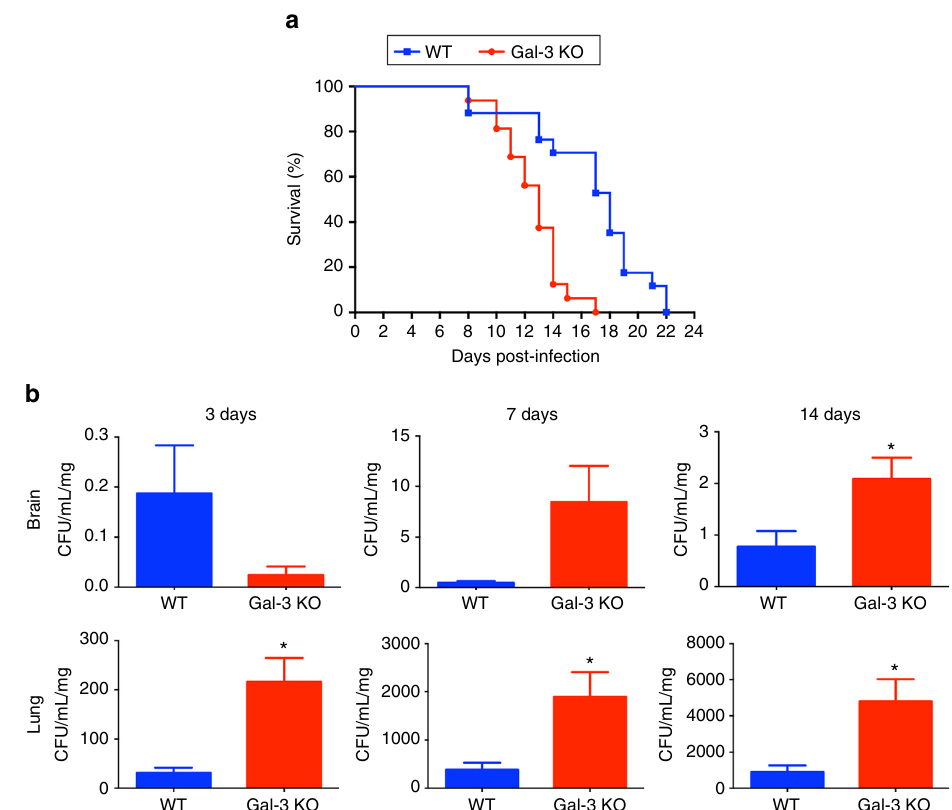
Fig. 3 Absence of Gal-3 leads to lower survival and increased fungal burden in experimental murine cryptococcosis. The survival rate ( a ) of Gal-3 KO mice (red line with circle) and WT mice (blue line with square) were veri fi ed after intratracheally infection with H99 yeast cells. b Colony-forming units (CFU) recovered from brain and lungs of WT (blue bars) and Gal-3 KO (red bars) mice were assessed after 3, 7, and 14 days after intratracheally infected with C . neoformans . The y -axis denotes CFU/ml/mg resulting from normalization of fungal burden to the weight of the organ fragment used to prepare the homogenate. Data are representative of three experiments, each performed with eight mice per group. The bars represent the mean ± SD of CFU obtained from triplicate samples in groups of eight animals. * p < 0.05, Student ’ s t -test, Gal-3 KO mice compared with WT